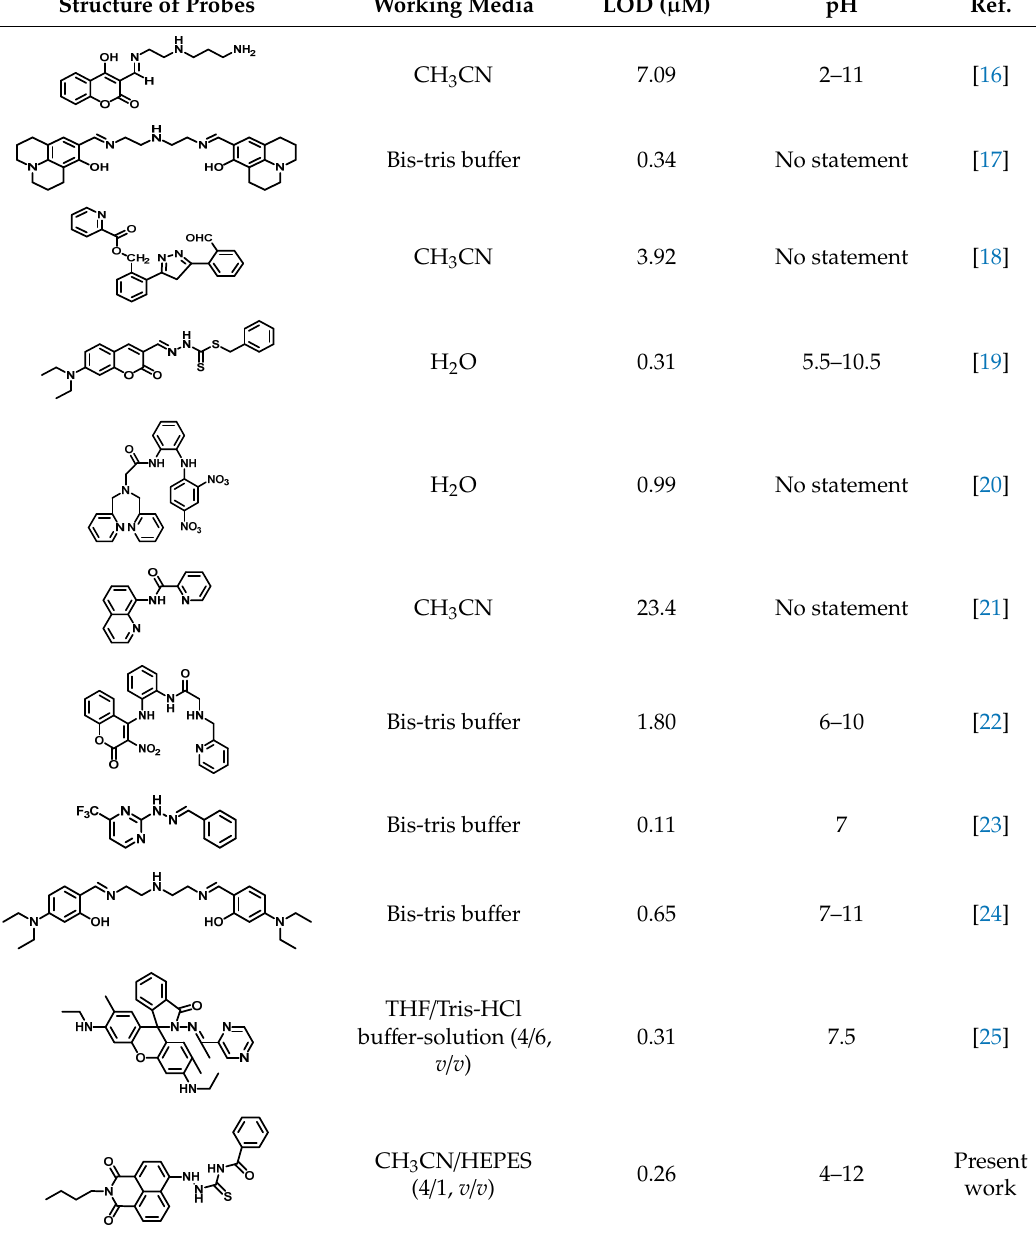
Molecules 2019 , 24 , x FOR PEER REVIEW Table 1. Comparison of the proposed L chemosensor with previously reported chemosensors for the Table 1. Comparison of the proposed L chemosensor with previously reported chemosensors for the Table 1. Comparison of the proposed L chemosensor with previously reported chemosensors for the determination of Co 2+ Table 1. Comparison of the proposed L chemosensor with previously reported chemosensors for the determination of Co 2+ . Table 1. Comparison of the proposed L chemosensor with previously reported chemosensors for the determination of Co 2+ . Table 1. Comparison of the proposed L chemosensor with previously reported chemosensors for the determination of Co 2+ . Table 1. Comparison of the proposed L chemosensor with previously reported chemosensors for the determination of Co 2+ . Table 1. Comparison of the proposed L chemosensor with previously reported chemosensors for the determination of Co 2+ . Table 1. Comparison of the proposed L chemosensor with previously reported chemosensors for the determination of Co 2+ . determination of Co 2+ . Table 1. Comparison of the proposed L chemosensor with previously reported chemosensors for the determination of Co 2+ . Table 1. Comparison of the proposed L chemosensor with previously reported chemosensors for the determination of Co 2+ . Table 1. Comparison of the proposed L chemosensor with previously reported chemosensors for the determination of Co 2+ . determination of Co 2 + .